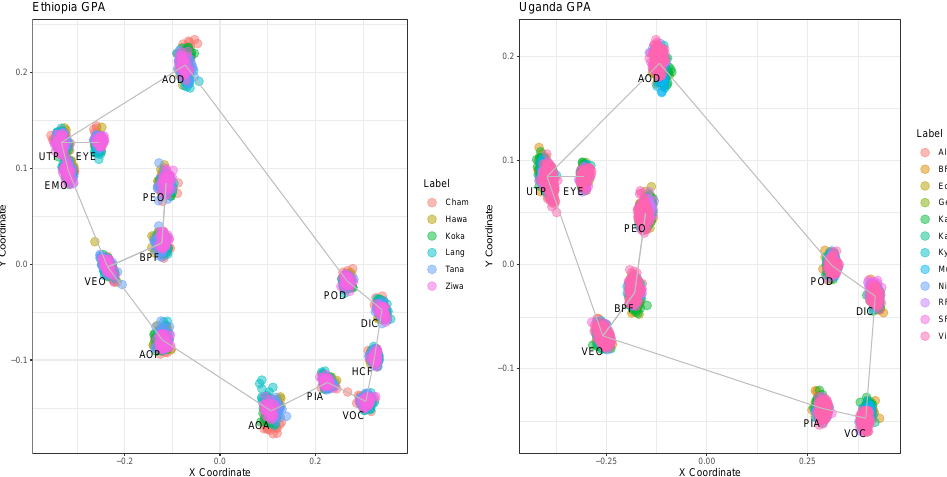
Figure 6. Visualization of the GPA coordinates for the population of Ethiopia ( left ) and Uganda ( right ).